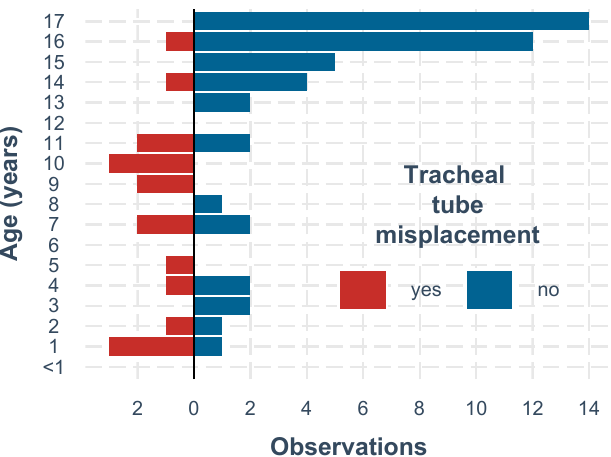
Figure 2. Tracheal tube misplacement and age.